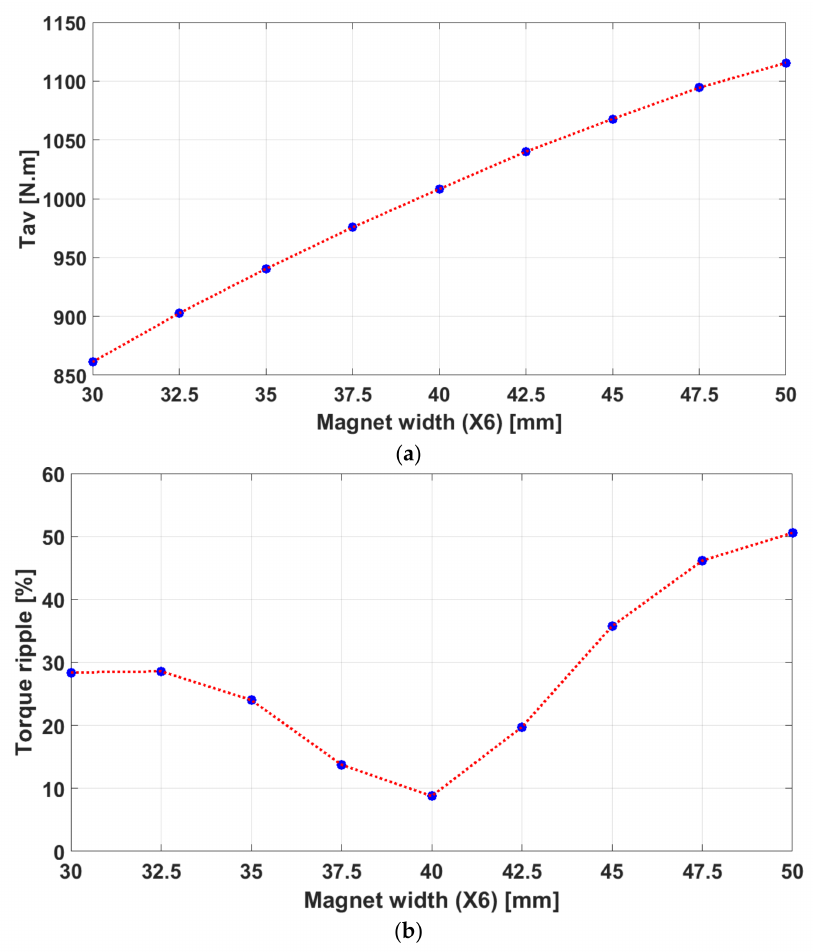
Figure 9. Impact of the central magnet width variation on: ( a ) the average torque; ( b ) the torque